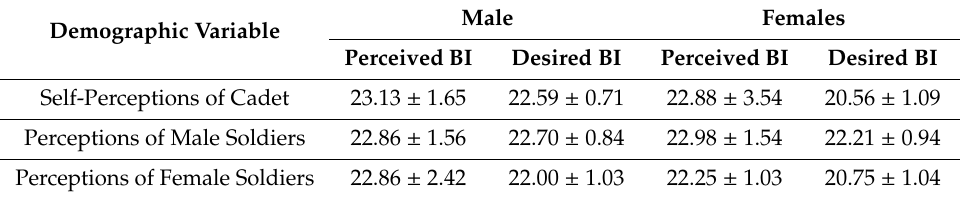
Table 5. Descriptive statistics for ROTC cadets reported self-perceptions, and perceptions of the ideal soldier. Values presented in mean and standard deviation of Body Mass Index. An α = 0.05 was used to determine